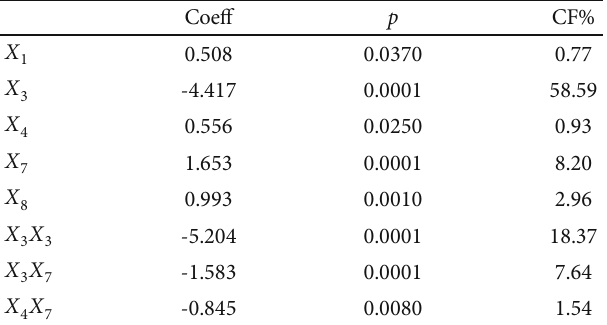
( 20 : 93 ± 0 : 12 g/l ) were compared to the predicted values ( 20 : 75 ± 00 g/l ) to validate the optimal conditions de fi ned by the model, and it was found that no signi fi cant di ff erence was observed between these two values ( p < 0 : 05 ).